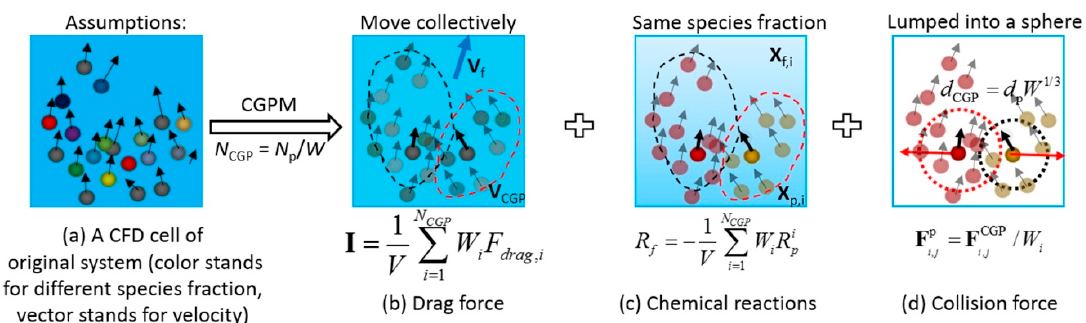
Figure 5. The coarse graining concept adopted by Lu et al. [70] for the simulation of liquid fluidized bed reactor. The statistic weight W is equivalent to the number of particles per grain n CG . Reprinted with permission from Reference [70]. Copyright (2016) American Chemical Society.